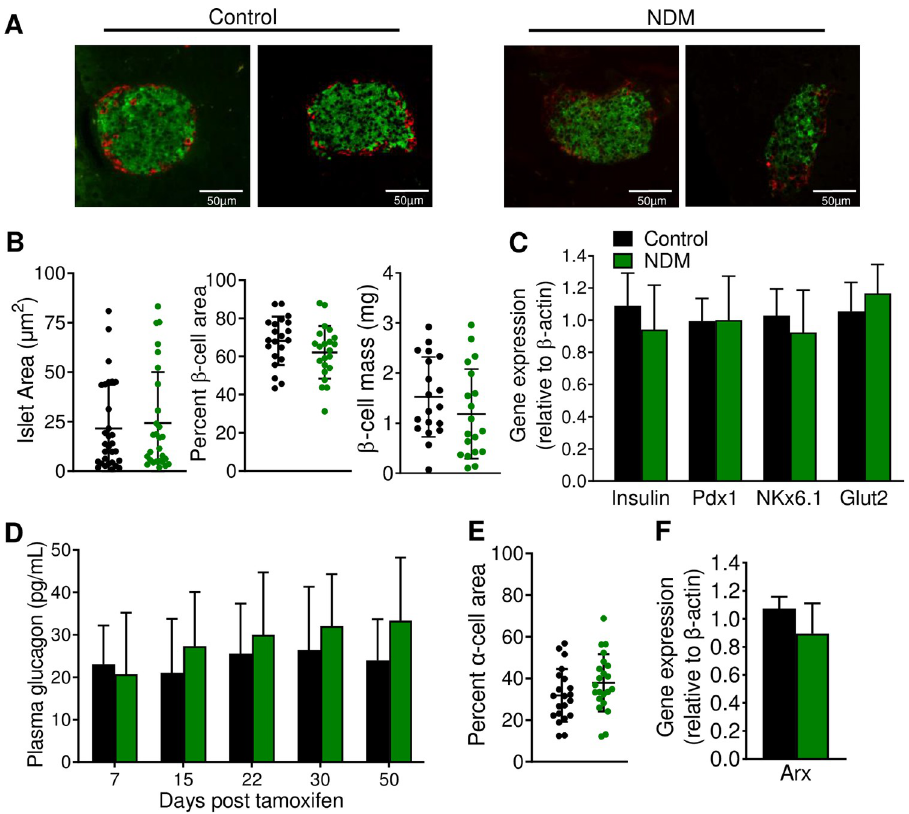
Fig 3. No changes in morphology or β -cell identity in islets from NDM mice at early stages of diabetes (A) Representative images of islets immunostained with insulin (green) and glucagon (red). (B) Islet area (left), Percent of β -cell area (middle) and β -cell mass (right) at day 15 of diabetes (n = 8 mice/group, 3 slides from each mouse). (C) Quantitative real-time PCR analysis of gene expression of mature β -cell identity markers in islets (n = 5–8 mice/group) at day 15 of diabetes. (D) Plasma glucagon over time during development and progression of diabetes. (E) Percent of α -cell area (n = 8 mice/group, 3 slides from each mouse), and (F) Quantitative real-time PCR analysis of gene expression of the α -cell identity marker Arx in islets at day 15 of diabetes (n = 4 mice/group). Black = controls and green = NDM at day 15 post-tamoxifen injection. Data are expressed as mean ± SD. inability of SGLT2i to improve β -cell function in animals with long-standing diabetes when they had already lost β -cell mass and identity.